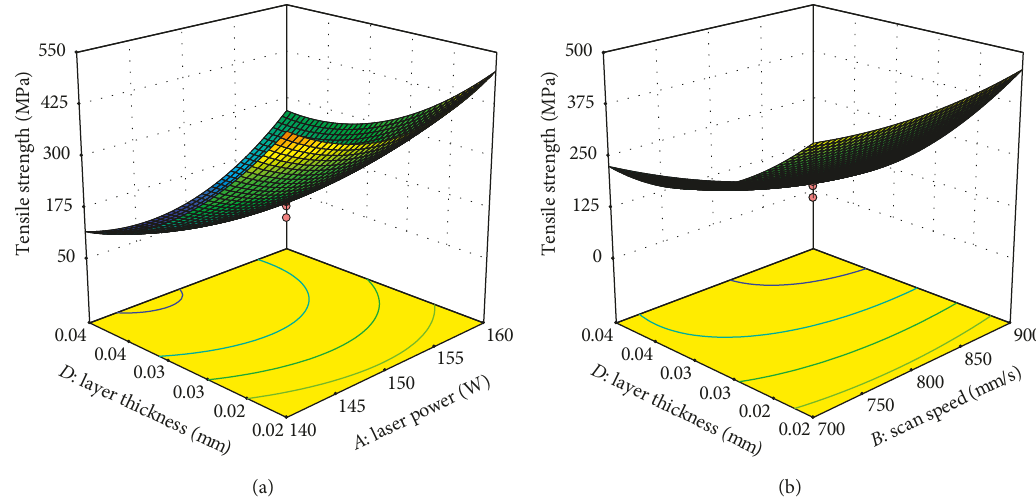
Figure 8: Effect of laser power, scan speed, and layer thickness on tensile strength. (a) Effect of interaction of laser power and layer thickness on tensile strength. (b) Effect of interaction of scan speed and layer thickness on tensile strength.